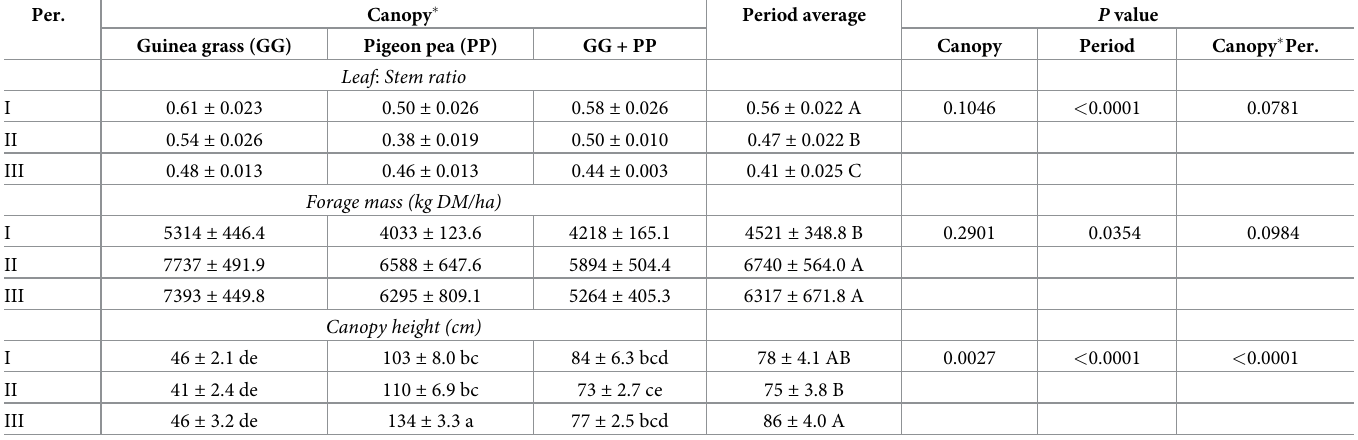
Table 2. Leaf: Stem ratio, forage mass and canopy height of different tropical pastures available to grazing lambs in southern Brazil at different experimental periods.